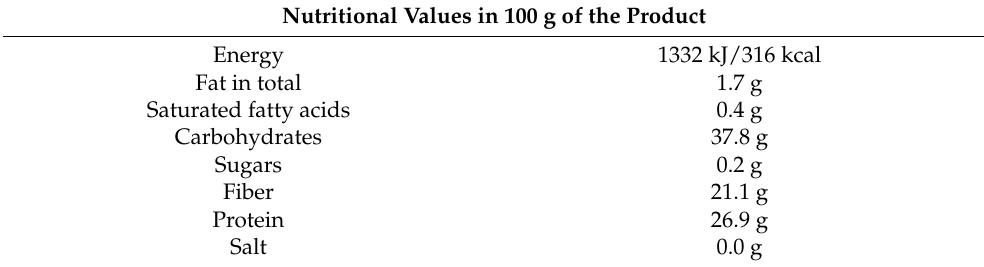
Table 1. Specification of the plant raw material 1